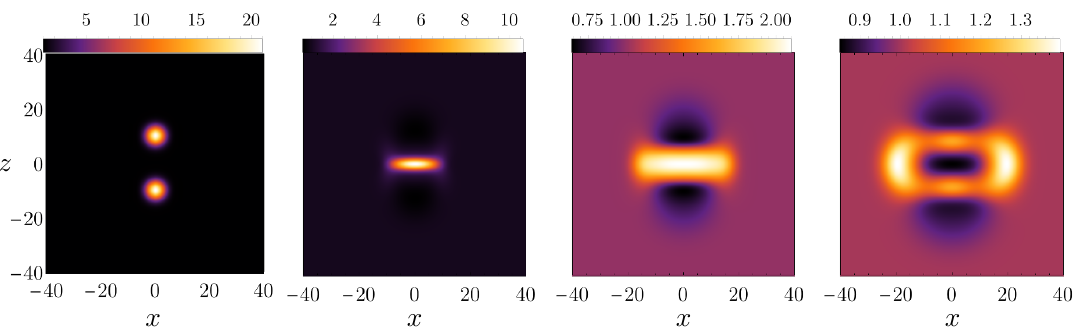
Figure 3 . Mass density at the collision plane at t = (0 , 4 , 8 , 12) . The collision corresponds to the head-on spherical blob collision from table 1.